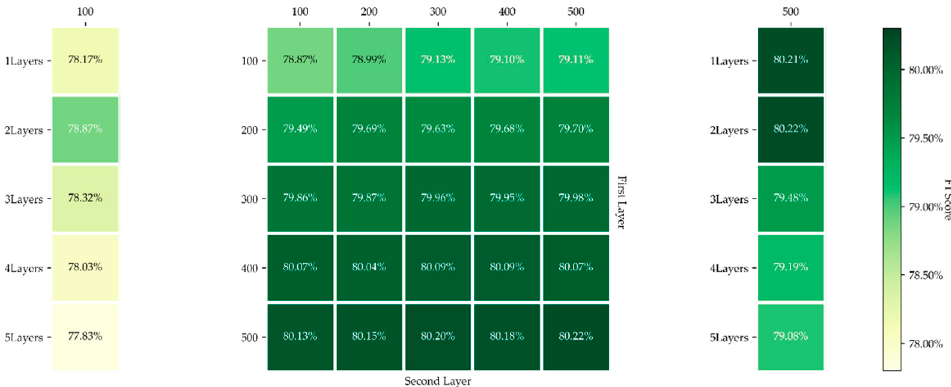
Figure 8. Results of network architecture search. Best viewed in color. The green map represents different F1 scores. The 5 × 5 grids in the middle show the F1 scores of models with two hidden layers, while the vertical and horizontal axis stands respectively for the number of neurons of the first and second layer. The 5 × 1 grids on the left side show the F1 scores of models with 1 to 5 hidden layers that have 100 neurons per layer, and the 5 × 1 grids on the right side show the F1 scores of models with 1 to 5 hidden layers that have 500 neurons per layer.